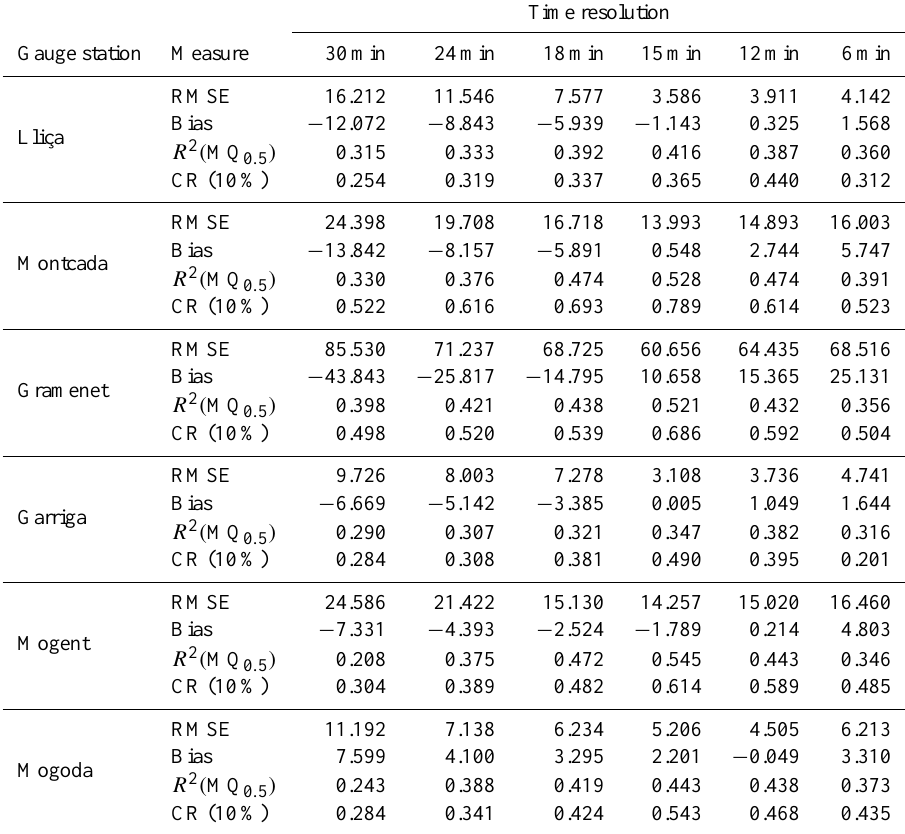
Table 6. Validation results for the selected river gauging